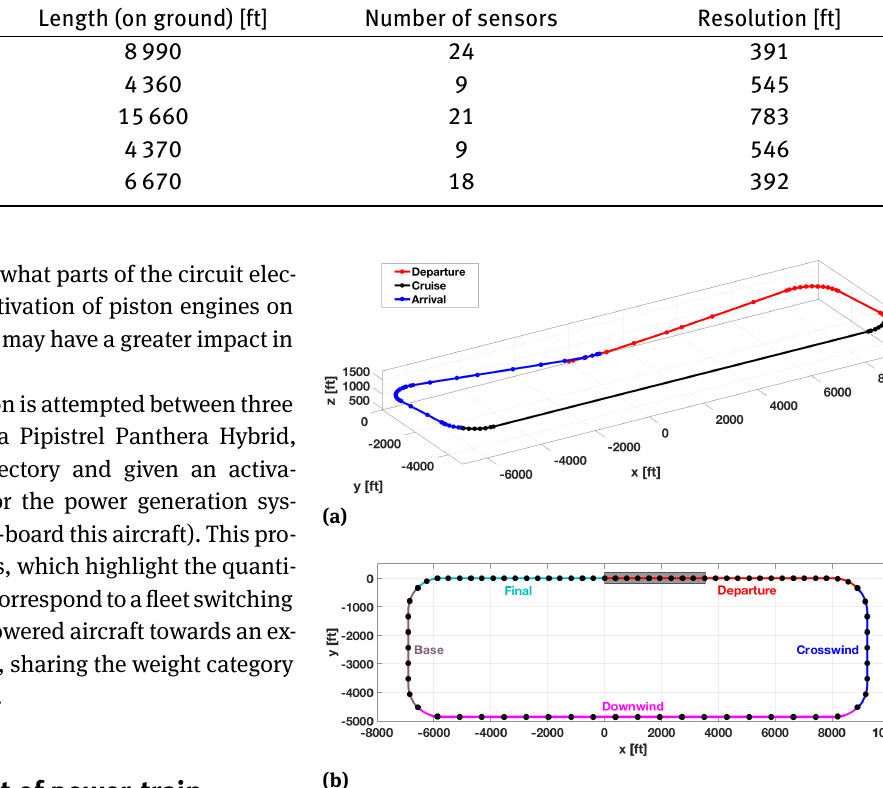
Table 5: Characteristics of the grid for the ground track of the circuit in Figure 5. Leg